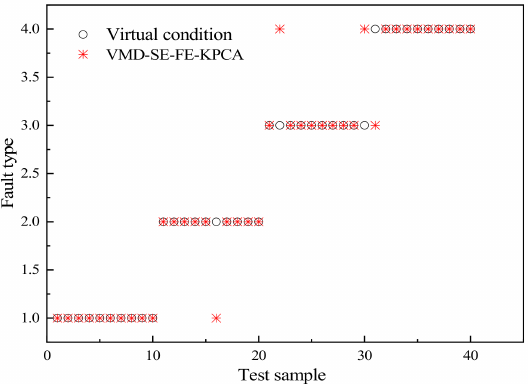
Figure 5. Prediction results of kernel extreme learning machine model based on